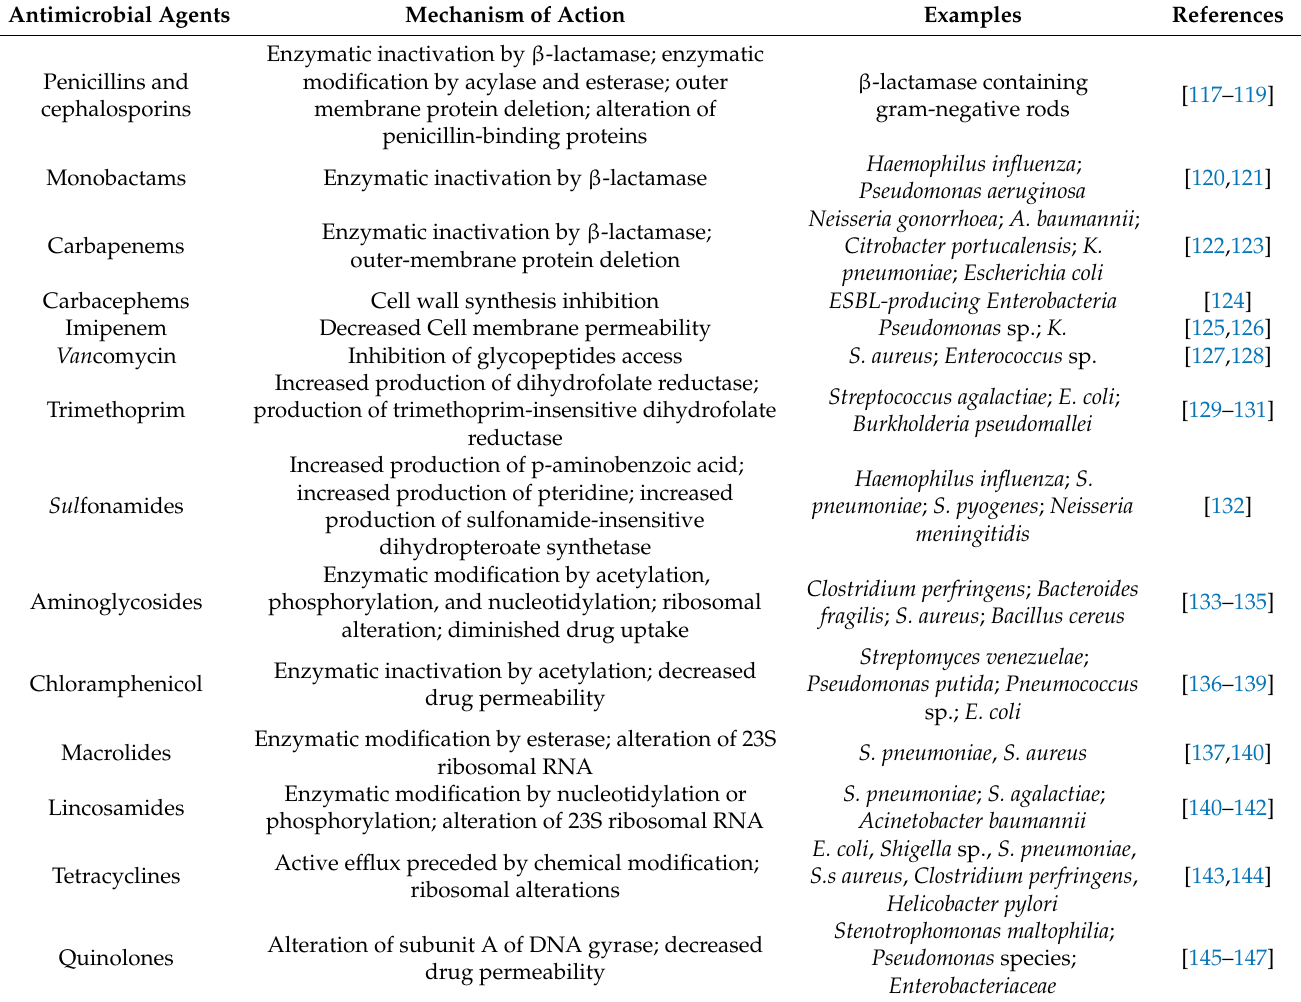
Table 3. Different mechanisms of antibiotic resistance with examples.